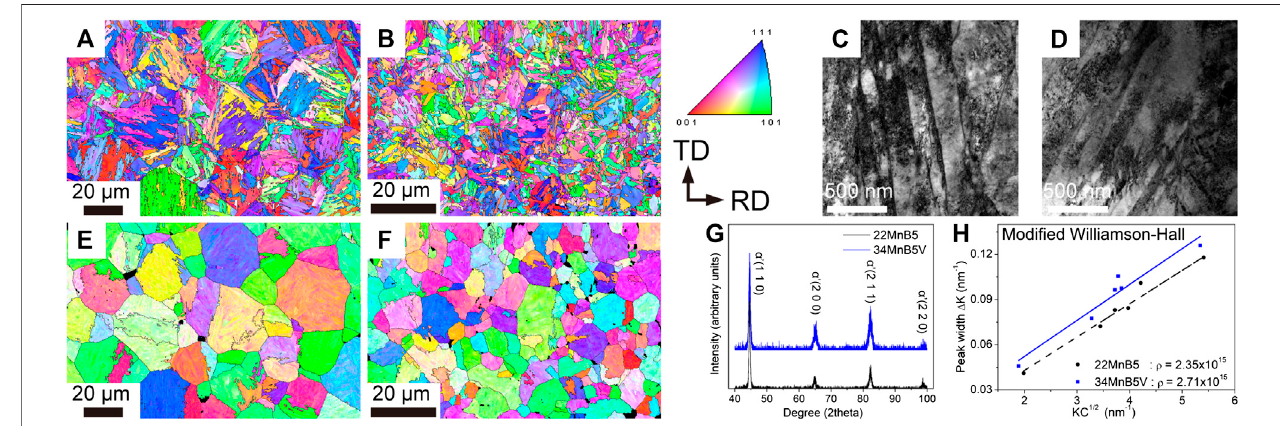
FIGURE3| EBSDIPFs-NDshowingmartensite microstructure in (A) 22MnB5 steeland (B) 34MnB5Vsteel; TEMmicrographsshowingmartensite microstructure in (C) 22MnB5 steel and (D) 34MnB5V steel; reconstructed IPF-ND showing prior austenite in (E) 22MnB5 steel and (F) 34MnB5V steel; (G) XRD spectra and (H) calculated dislocation densities by modi fi ed Williamson – Hall method and TEM characterizations.